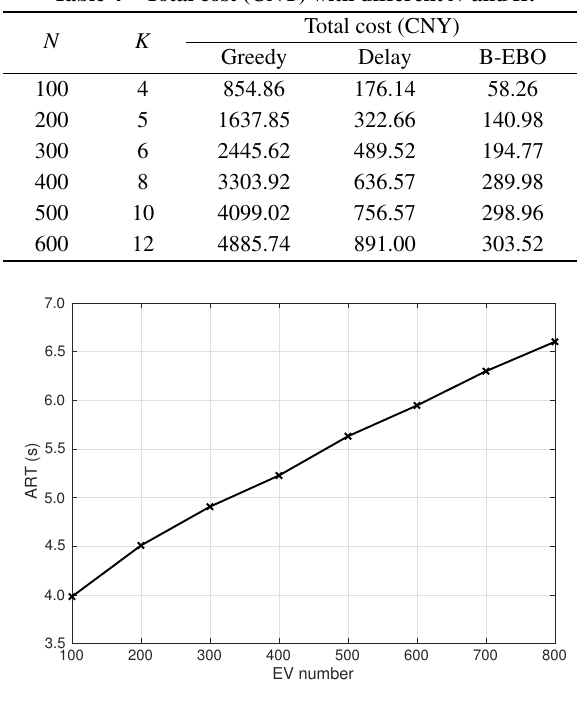
Fig. 6 ART with different EV